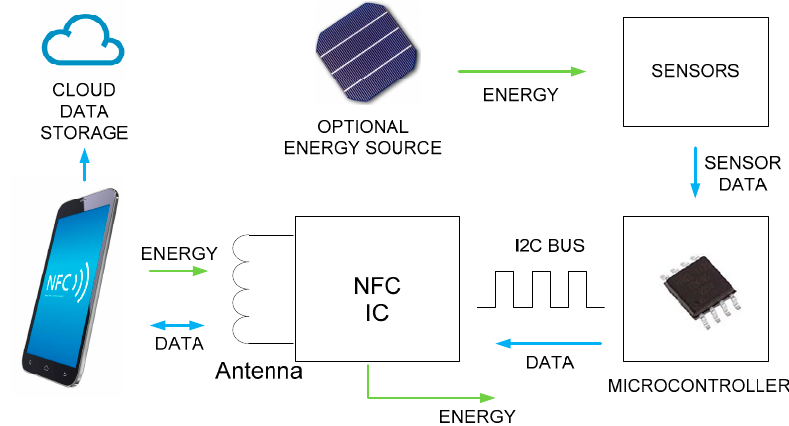
Figure 1. Block diagram of a green near-field communication (NFC)-based sensor system.